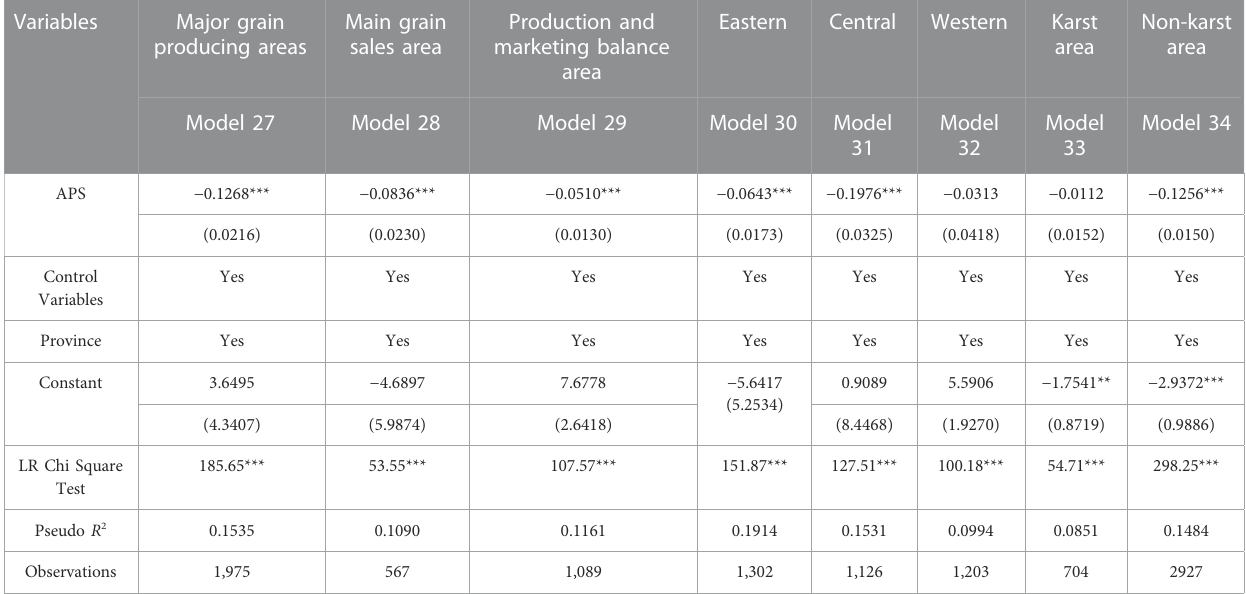
TABLE 6 Estimated results of regional heterogeneity.